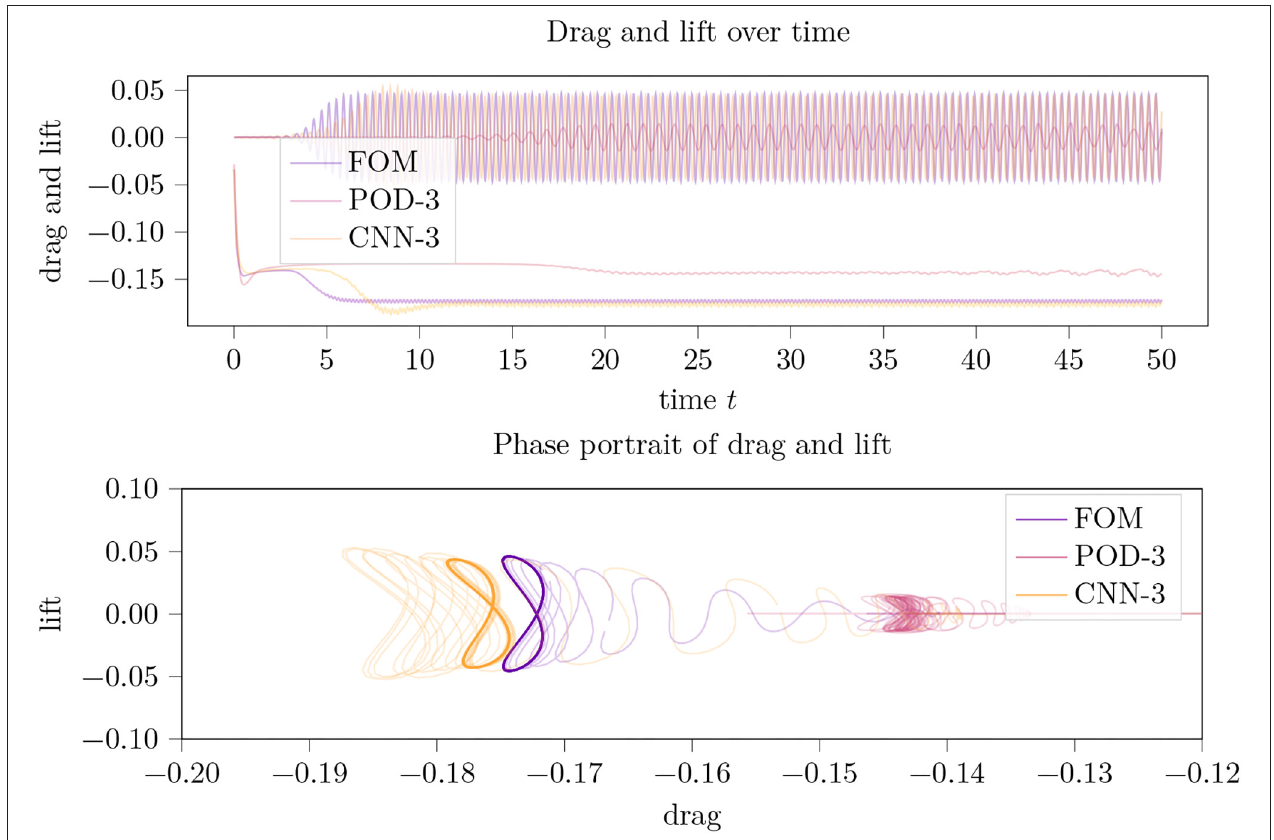
FIGURE 4 | Drag and lift trajectories (top) over time and their phase portrait (bottom picture) for an LPV approximation of the incompressible flow around a 2D cylinder using a parameter dimension of cs = 3 .